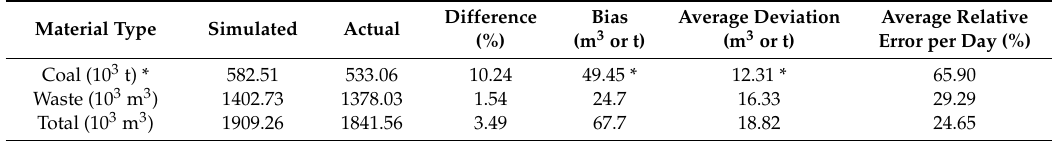
Table 10. Summary statistics of simulated and actual production data of the case Profen, Exp.